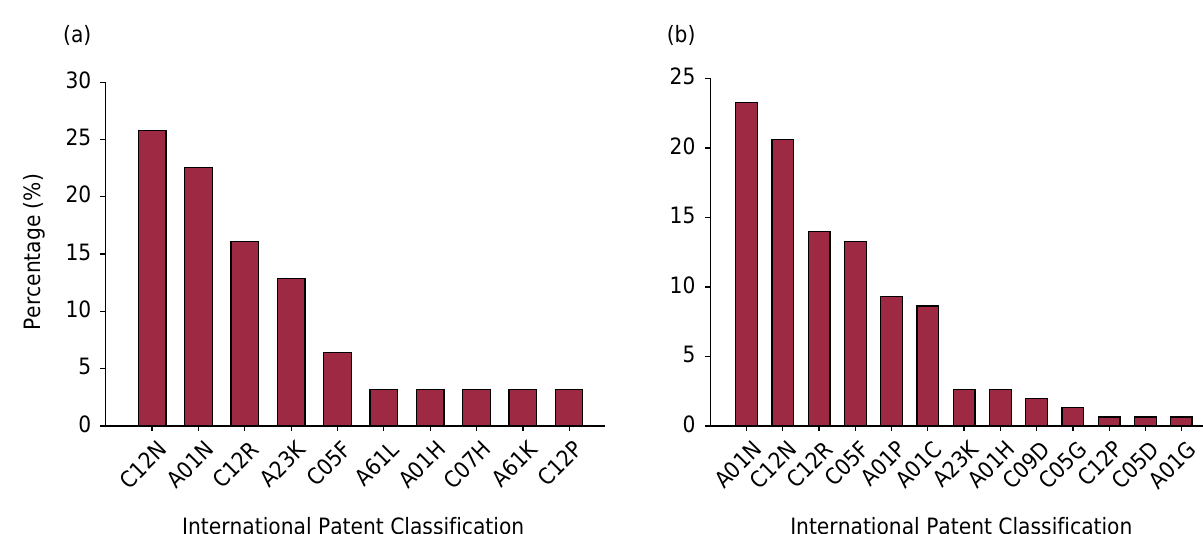
Figure 2. International classification (WIPO, 2021) of all patents found from 1981 to 2000 (a) and from 2001 to 2020